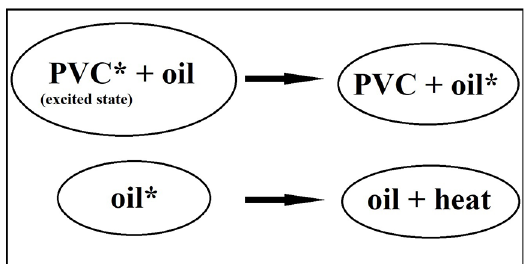
Scheme 1. Proposed mechanism of OCG action in PVC molecule exposed to gamma